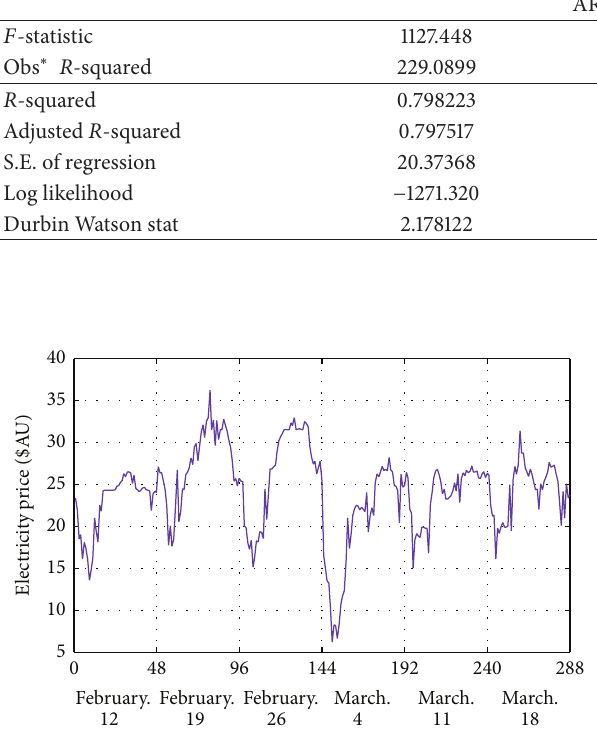
Figure 2: The actual electricity price data of six Mondays in New South Wales of Australia in